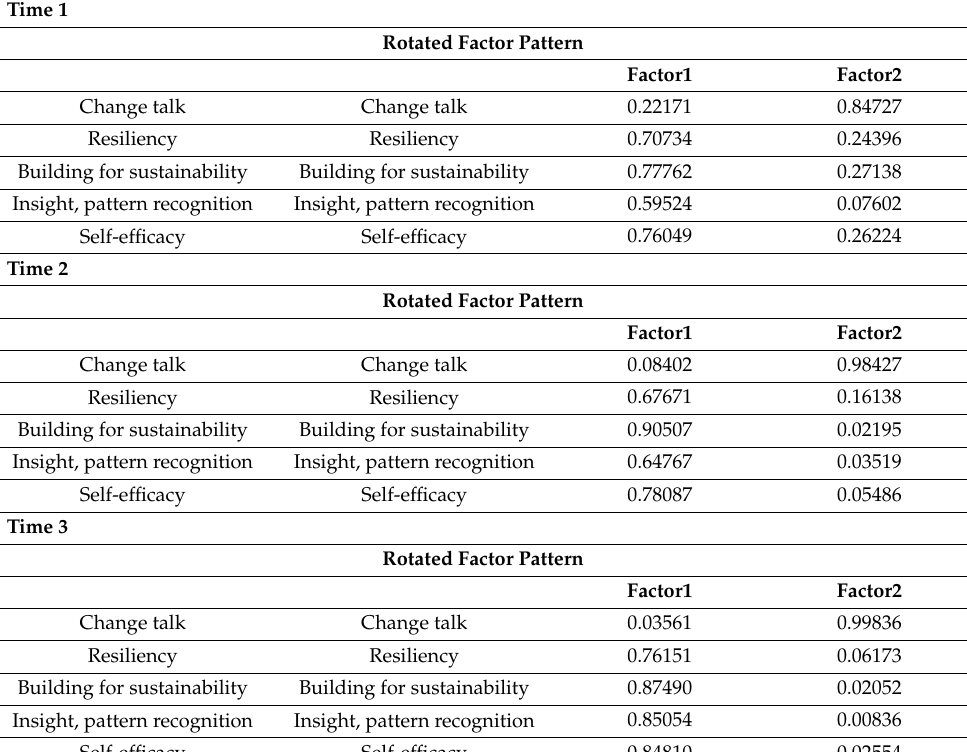
Table 4. Factor Analysis of Variables at Each of Three Time